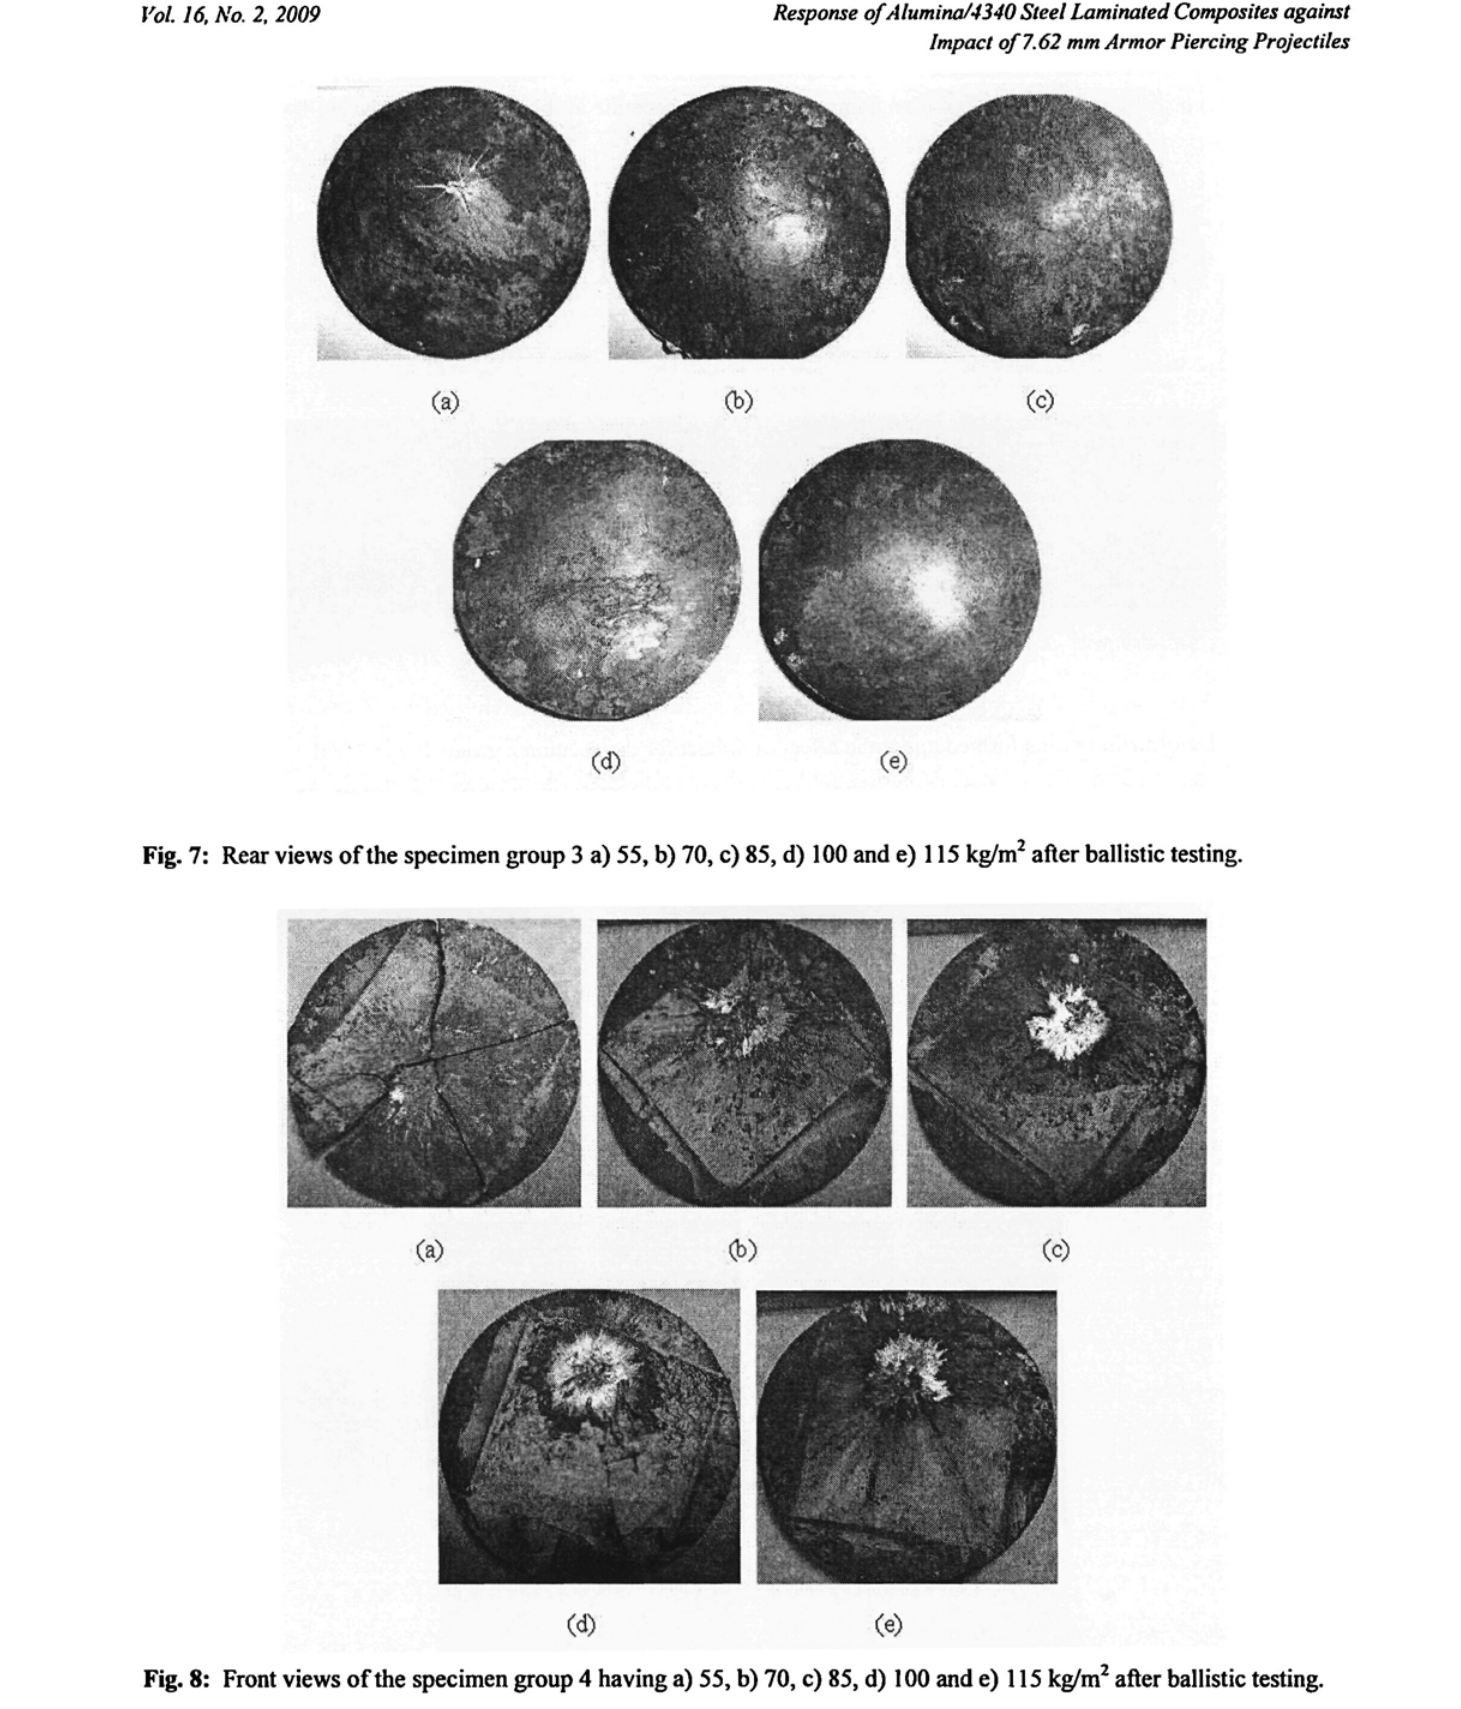
Fig. 8: Front views of the specimen group 4 having a) 55, b) 70, c) 85, d) 100 and e) 115 kg/m 2 after ballistic